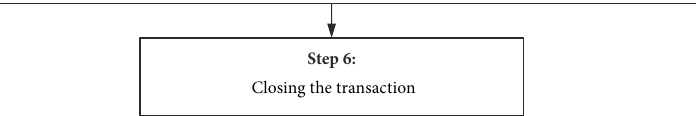
Figure 2. Scheme of registration in the system and purchase – sale transactions in the Zielony for entities joining the system (source: own